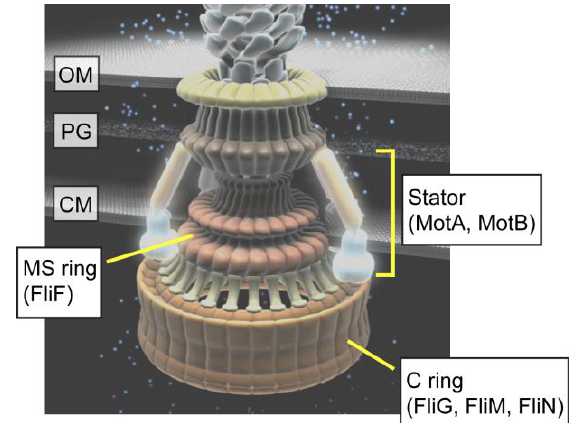
Figure 2. Schematic diagram of the proton-driven bacterial flagellar motor. The flagellar motor consists of a reversible rotor made of FliF, FliG, FliM and FliN and a dozen stators, each of which consists of MotA and MotB. FliF forms the MS ring within the cytoplasmic membrane. FliG, FliM and FliN form the C ring on the cytoplasmic face of the MS ring. OM, outer membrane; PG, peptidoglycan layer; CM, cytoplasmic